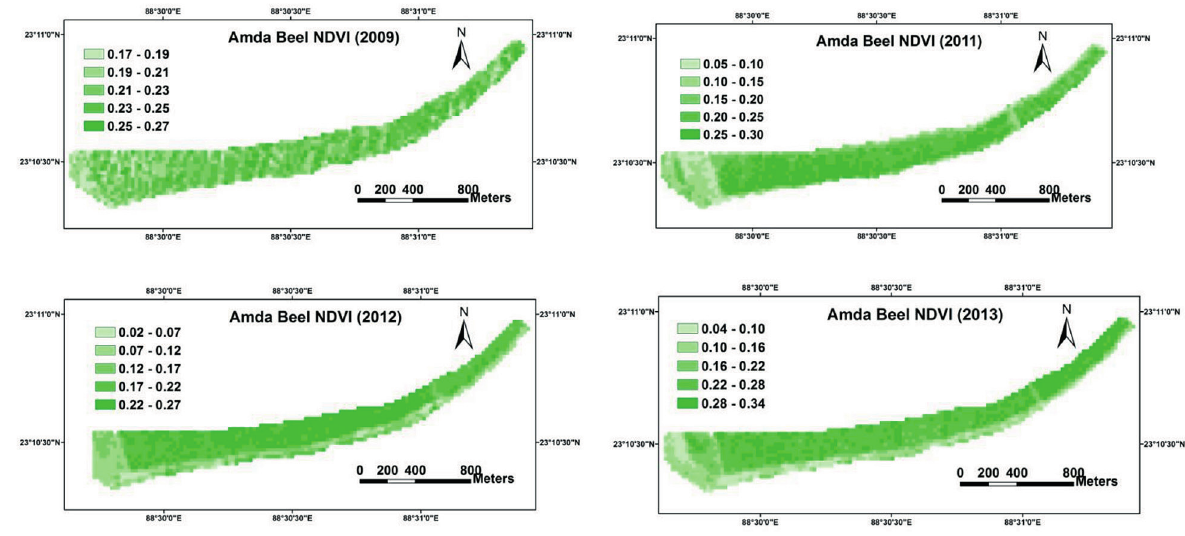
Fig. 3. NDVI maps and its temporal changes in vegetation from 2009–2013.